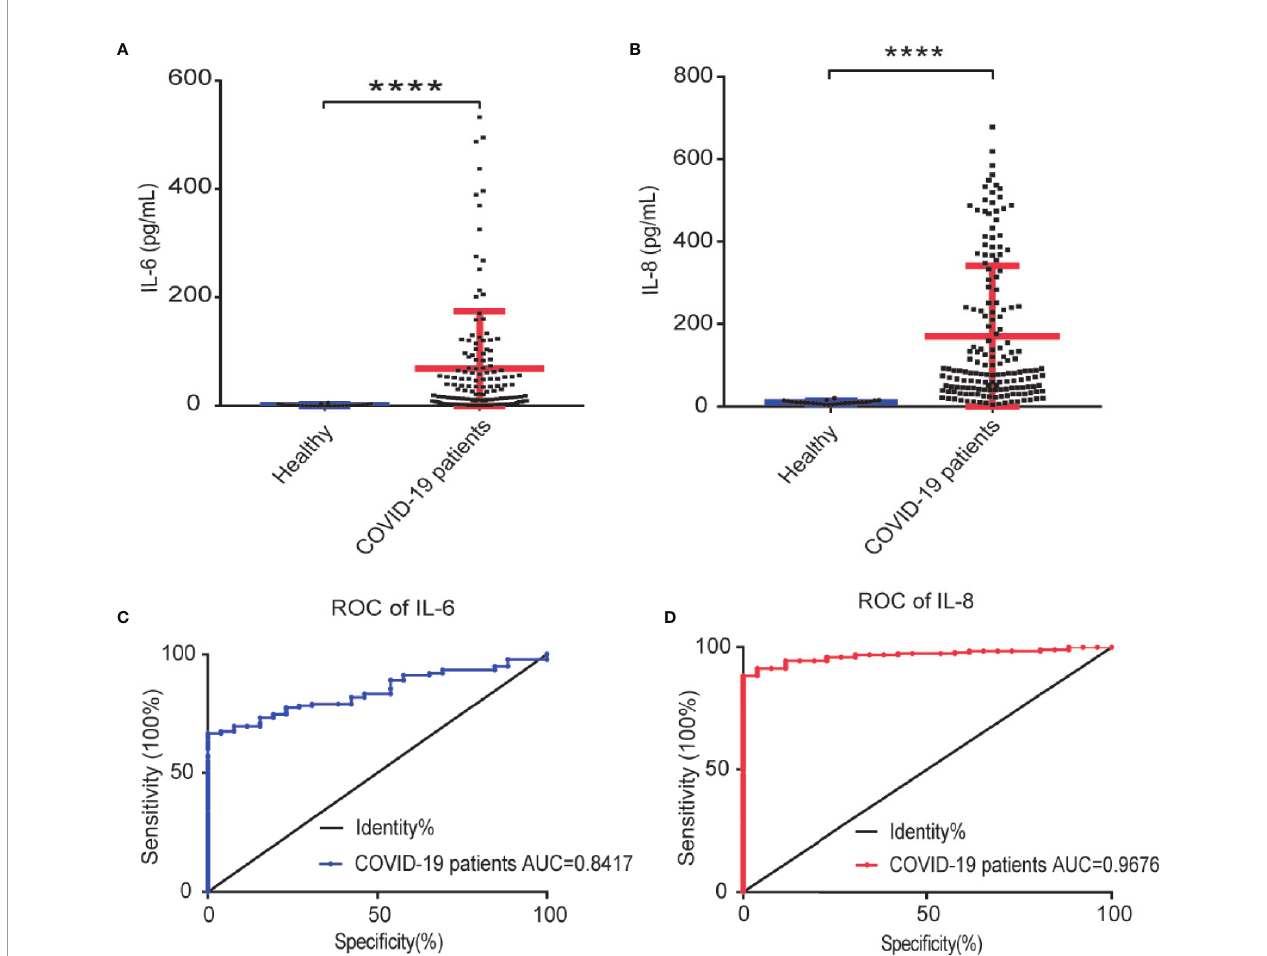
FIGURE 3 | IL-8 performed better in distinguishing COVID-19 patients from healthy people. (A, B) Scatter plot of IL-6 (A) and IL-8 (B) levels detected by ELISA in healthy and COVID-19 patients ’ sera. (C, D) The detectability performance of IL-6 (C) and IL-8 (D) in COVID-19 patients was estimated using ROC curve analysis and compared with the AUC. ELISA data (A, B) are shown as Mean±SEM, **** p <0.0001, unpaired Student t